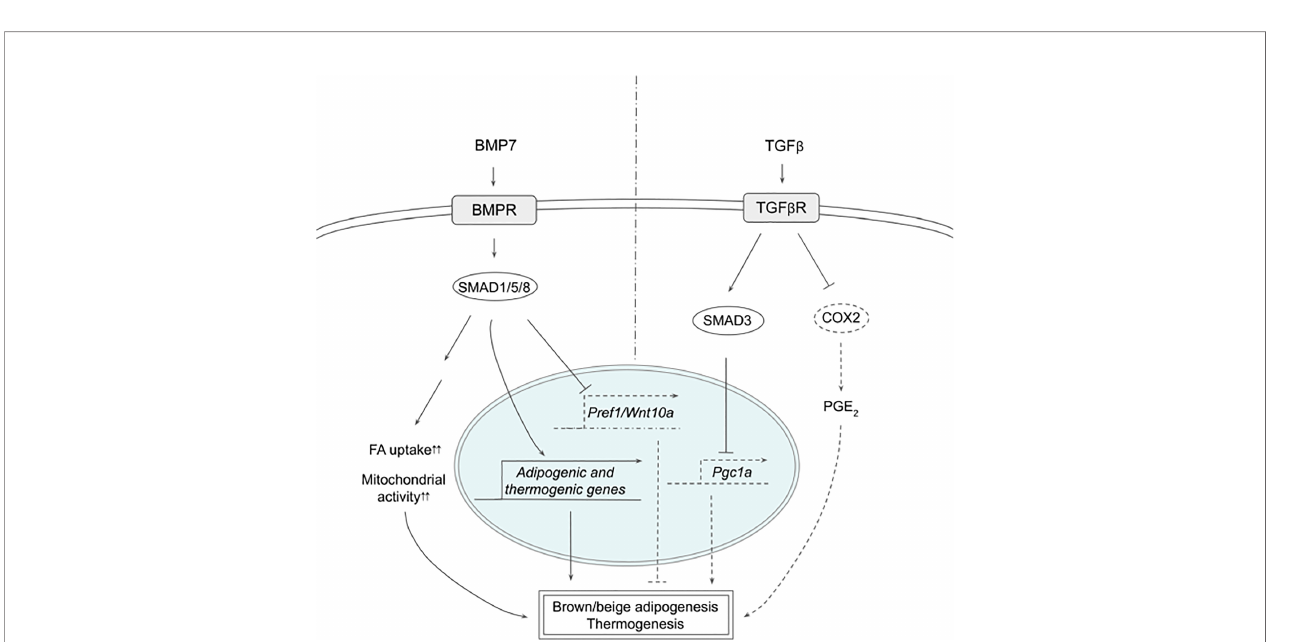
FIGURE 2 | Schematic models of BMP7 and TGF b signaling pathways in thermogenesis. BMP7 binds TGF b R, which activates SMAD1/5/8, leading to expression of adipogenic and thermogenic genes as well as suppression of Pref1 and Wnt10a in precursor cells to promote brown and beige adipogenesis. In mature adipocytes, BMP7 signaling increases FA uptake and mitochondrial activity, resulting in enhanced thermogenesis. TGF b activates SMAD2/3 that suppresses PGC1 a expression and COX2/PGE2 pathway to reduce thermogenesis. See text for details. BMP7, bone morphogenetic protein 7; COX2, cyclooxygenase 2; FA, fatty acid; PGC1 a , peroxisome proliferator activated receptor g ; PGE2, prostaglandin E2; PREF1, preadipocyte factor 1; SMAD, mothers against decapentaplegic homolog; T b R1, TGF b receptor 1; TGF b , Transforming growth factor beta; TGF b R, TGF b receptor; WNT10a, Wnt family member 10A.